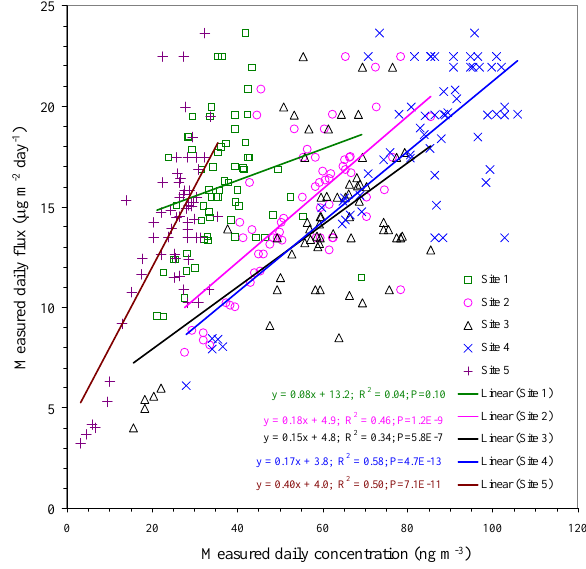
Fig. 3. Correlation between measured daily fluxes (µgm − 2 day − 1 ) and measured daily concentrations (ngm − 3 ) for Mn at the five